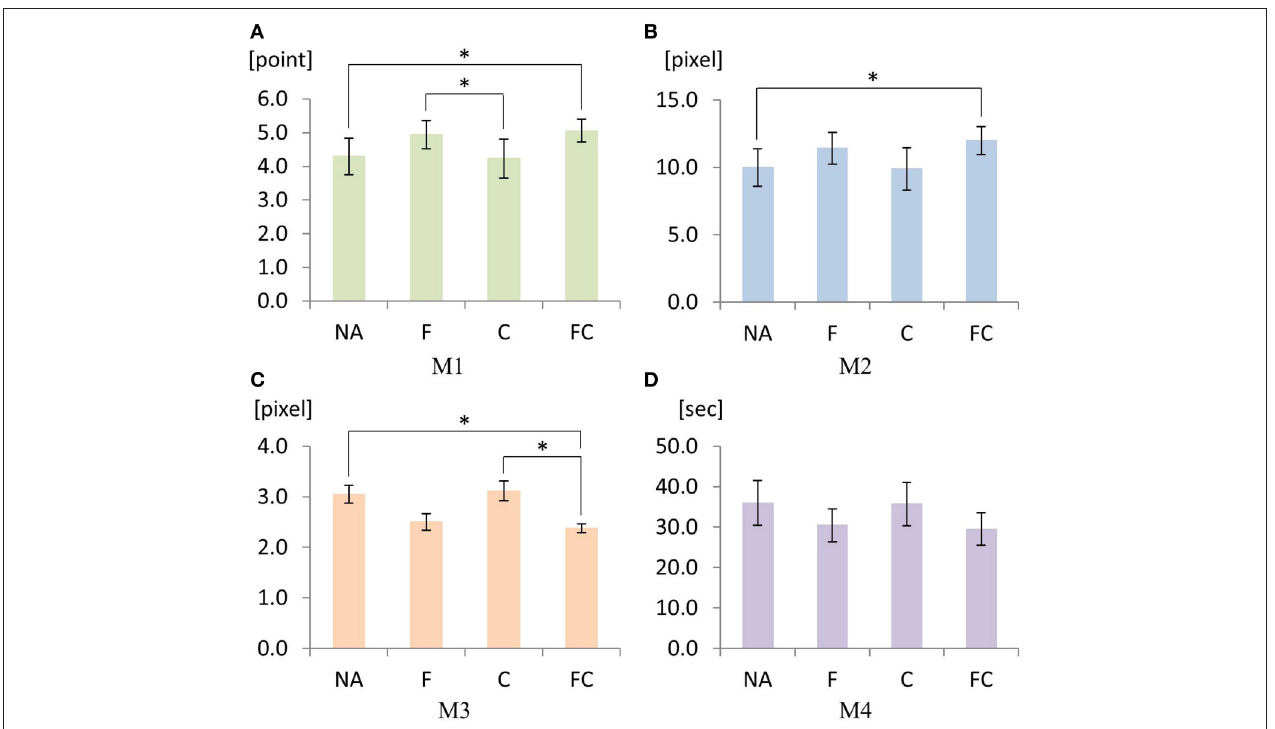
FIGURE 11 | Mean values for M1 (A) through M4 (D) under four augmented sensory feedback conditions: NA (no feedback augmentation), F (force feedback augmentation by the haptic joystick), C (cutaneous skin stretch feedback augmentation by the skin-stretcher), and FC (force feedback and cutaneous skin stretch feedback augmentations). An error bar represents standard error. Significances are indicated by “ * ” for p < .05 resulted from Bonferroni adjusted pairwise